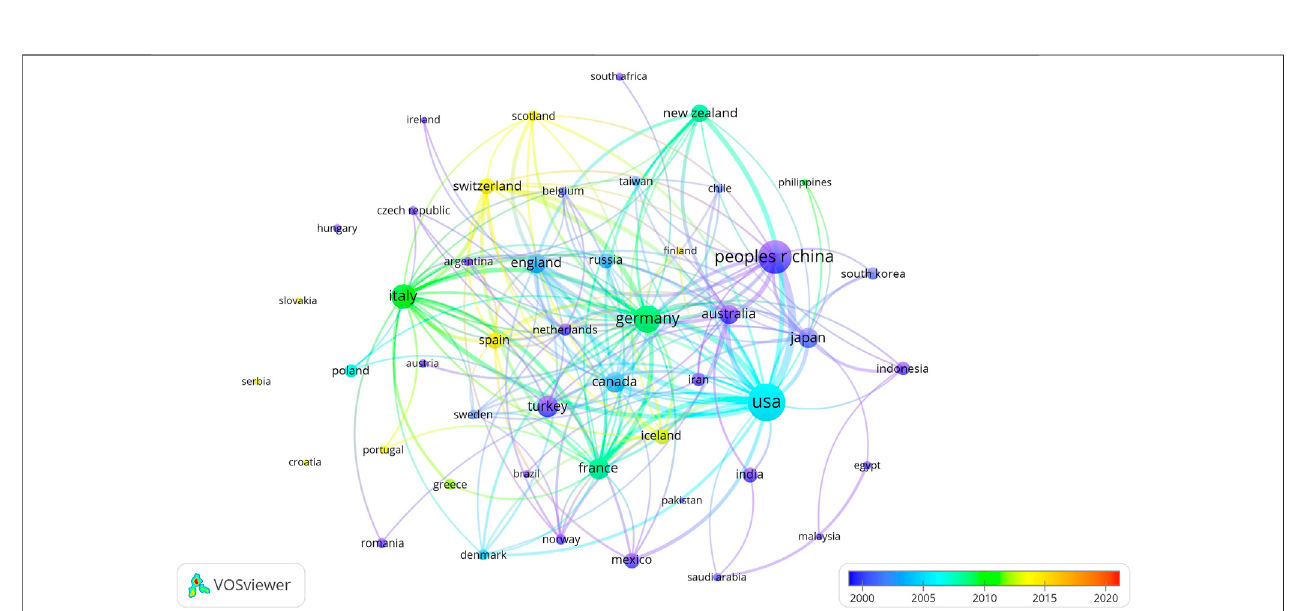
FIGURE 3 | Mapping knowledge domain about co-authorship of